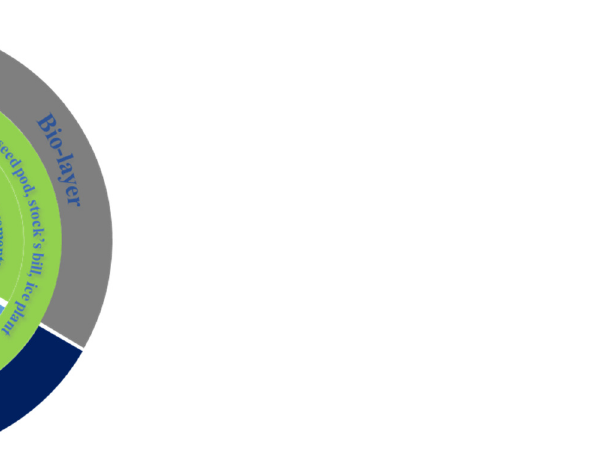
Figure 1. Plant-inspired soft robotics: nastic movements in plants and derived design principles for biomimetic soft robotics.